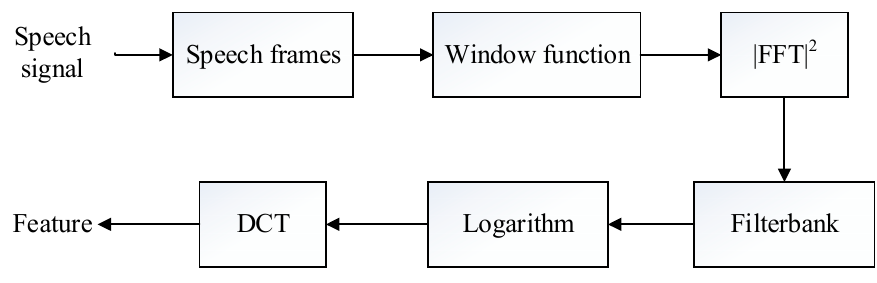
Figure 3. MFCC, LFCC extraction process.